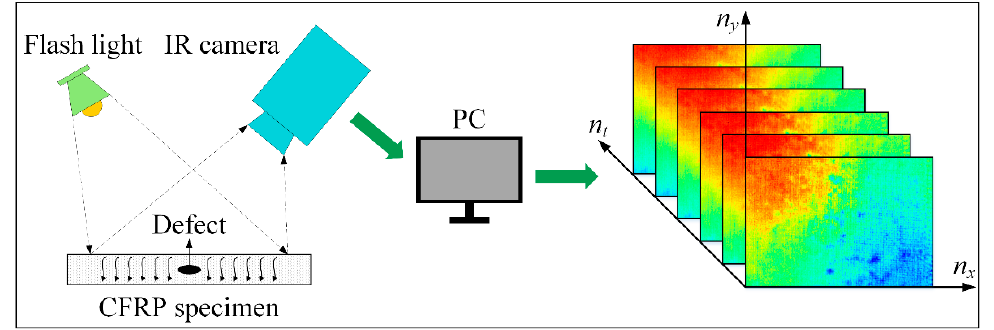
Figure 3. The PT inspection equipment and acquired thermogram sequence.